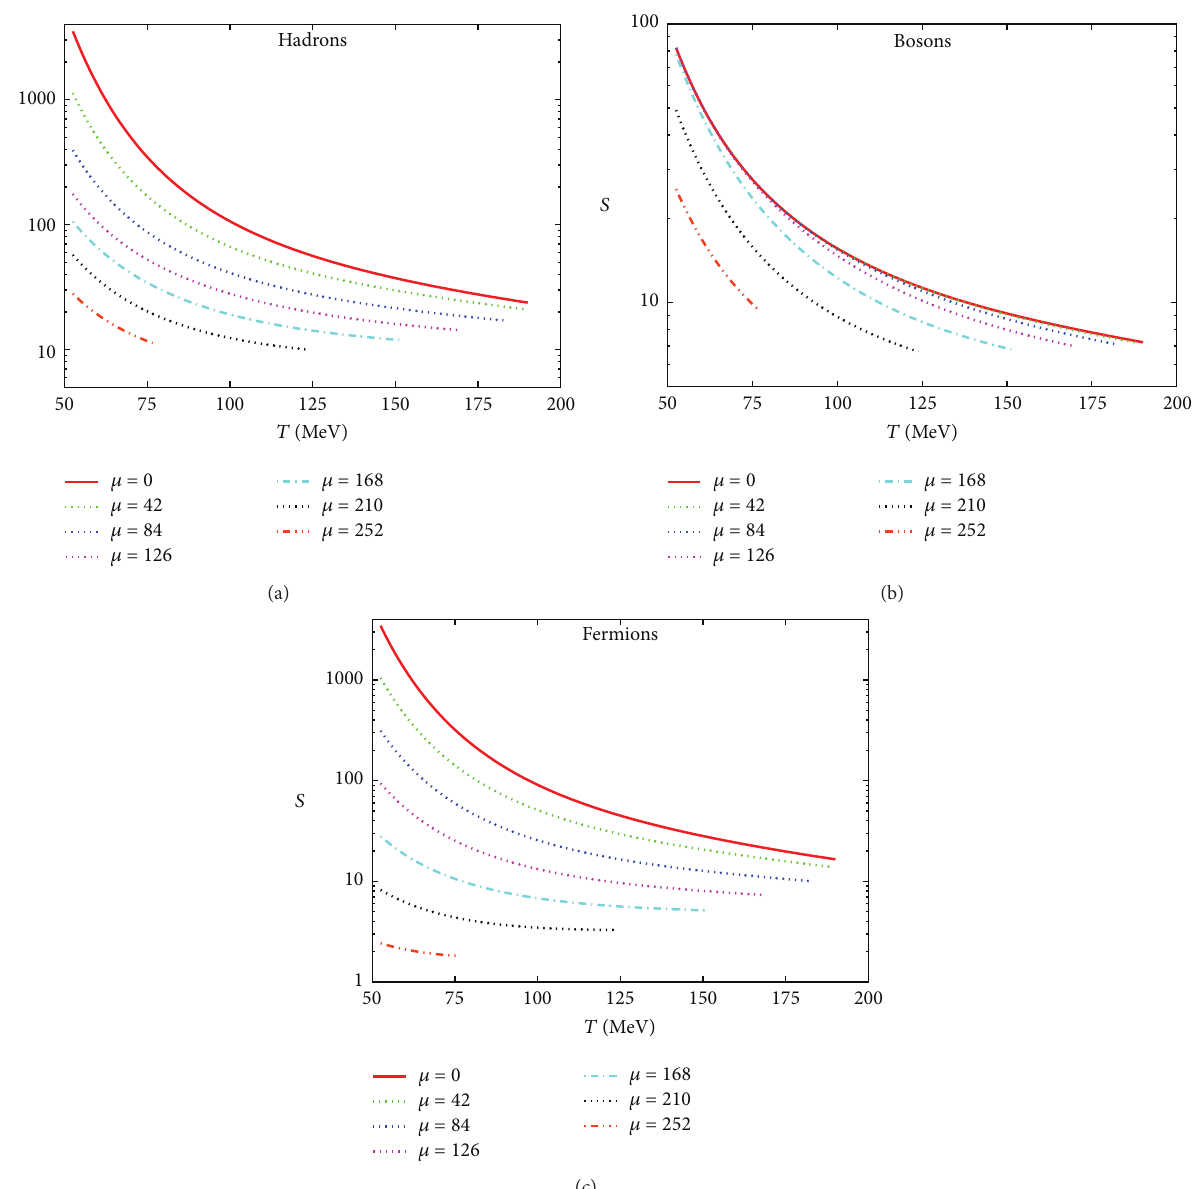
Figure 3: At various baryon chemical potentials (given in MeV), the skewness 𝑆 for hadronic (a), bosonic (b), and fermionic (c) resonance gas is given as function of 𝑇